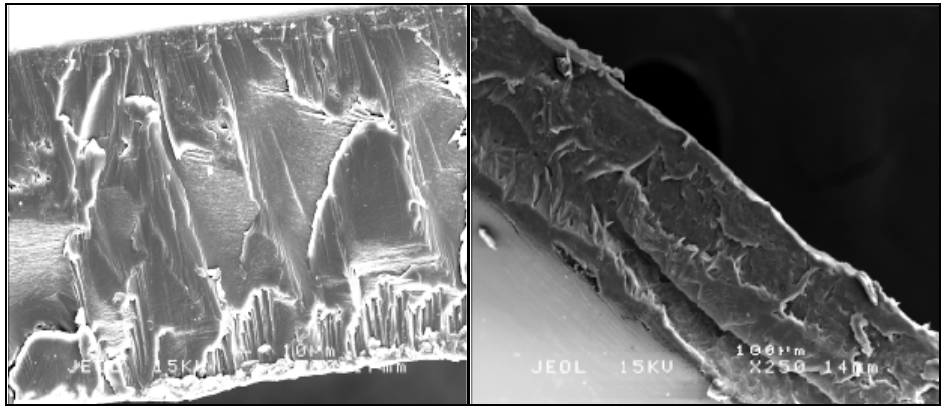
Figure 3. SEM image of the cross section of CA (JEOL 15KV, magnification 500